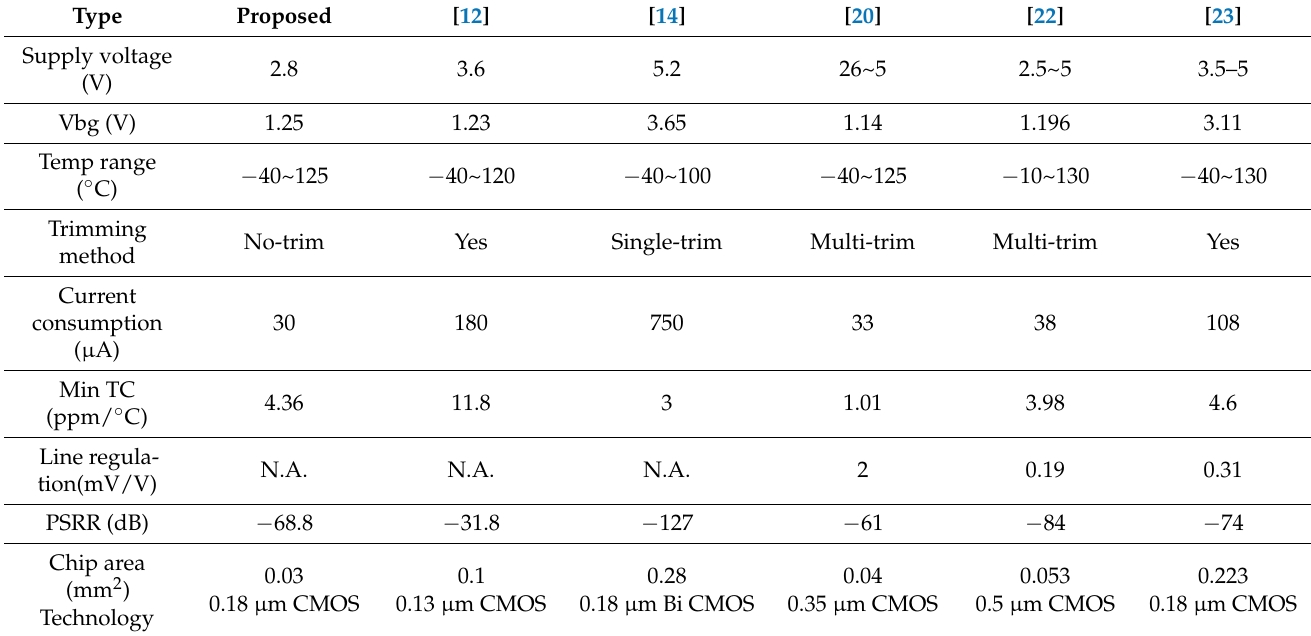
Table 7. Performance summary and comparison with other bandgap reference